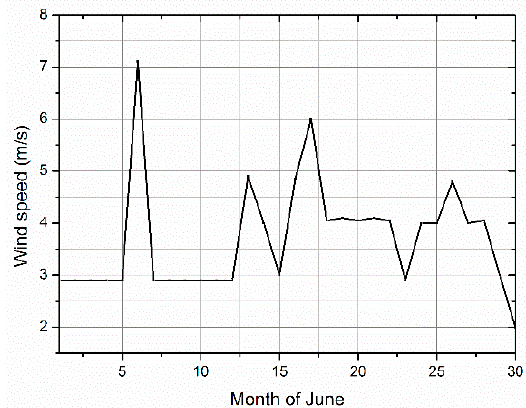
Figure 5. Wind speed measurement record (2018.06, Nanjing, Jiangsu, China).